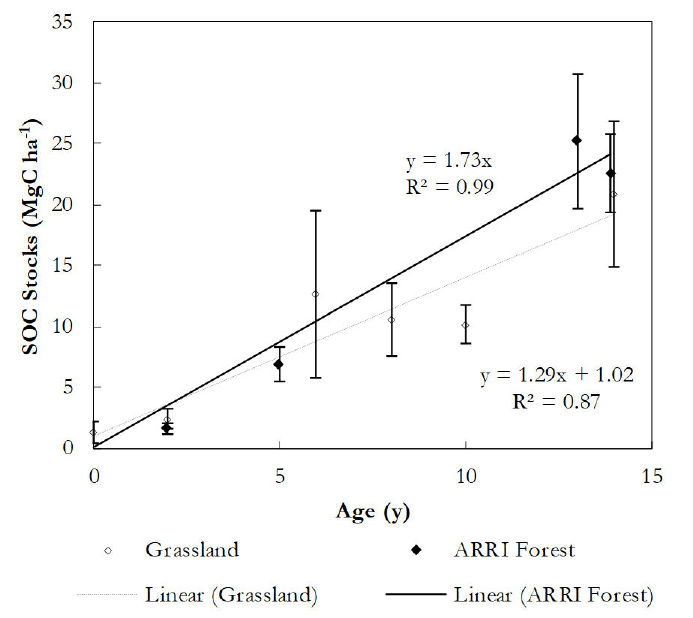
Figure 8. Measured SOC stocks the ARRI reforestation experiment reported in this study (squares). For comparison, previously published data from a grassland experiment of Acton et al. [1] are also plotted